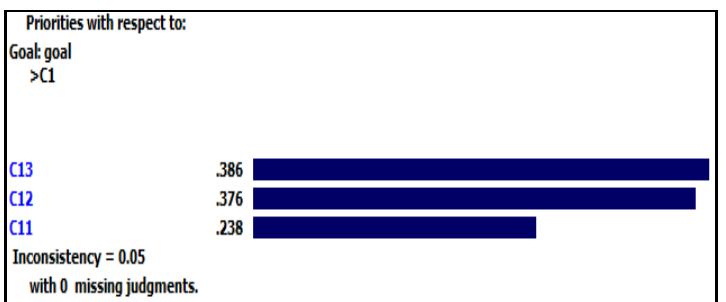
Fig. 4. Weights of export marketing